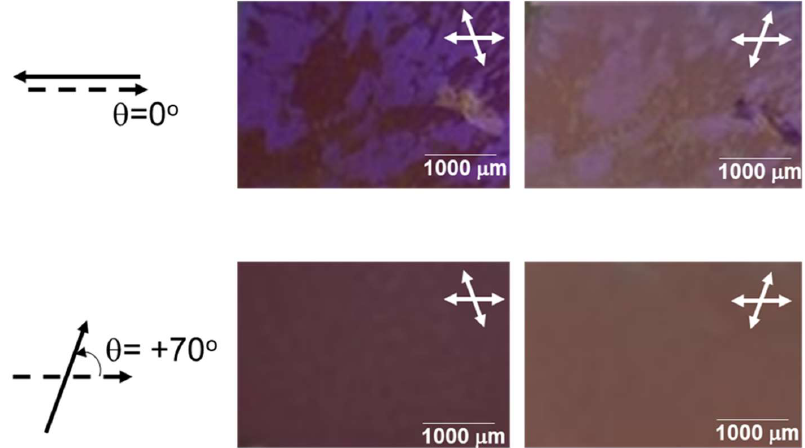
Figure 3. Typical polarized optical microscopy (POM) images displaying the textures of the refilled binary mixture in the cells with extrinsic TN platforms, at a twisted angle θ = 0° (antiparallel) and θ = +70° (corresponding to a clockwise, left-handed twist) under slightly decrossed polarizers.